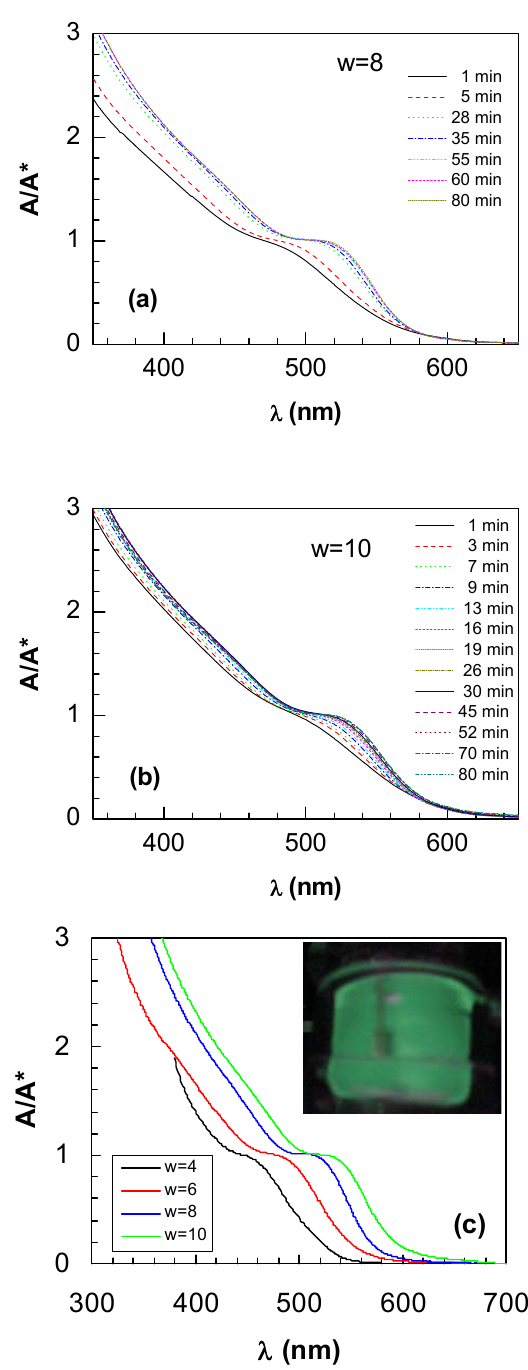
Fig. 4 Absorbance spectra of CdSe nanoparticles in the system water/AOT/benzene as a function of time at: (a) w =8 and (b) w =10. The growth time increases from left to right. (c) Visible spectra of CdSe particles synthesized at different w ratio increasing from left to right. The inset depicts the final suspension of CdSe nanoparticles in heptane, which show green photoluminescence (PL) under UV-light illumination. In this case ( w =4) the nanoparticles diameter is 1.93